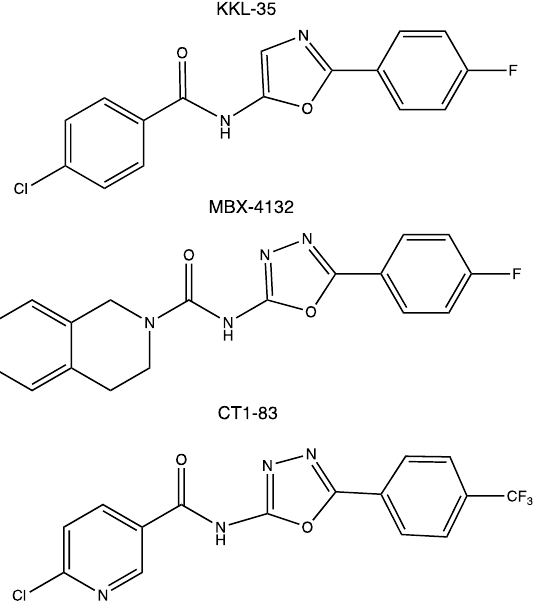
Figure 4. Chemical structures of the experimental oxadiazole compounds KKL-35, MBX-4132, and CT1-83.